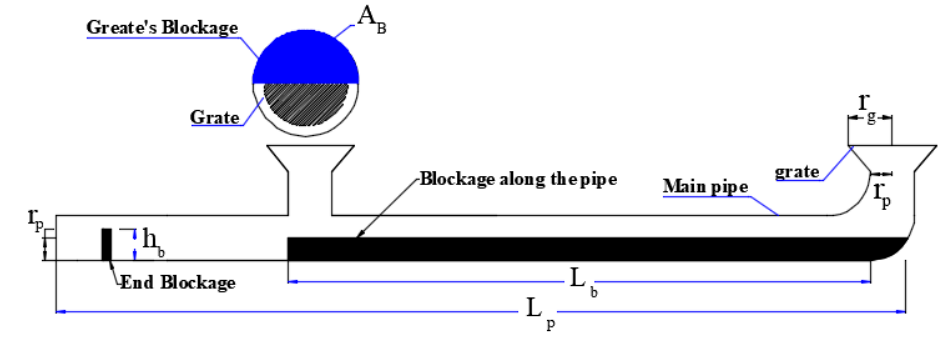
Water 2020 , 12 , x FOR PEER REVIEW Figure 3. Longitudinal cross section of flume and main pipe system. Figure 3. Longitudinal cross section of flume and main pipe system.